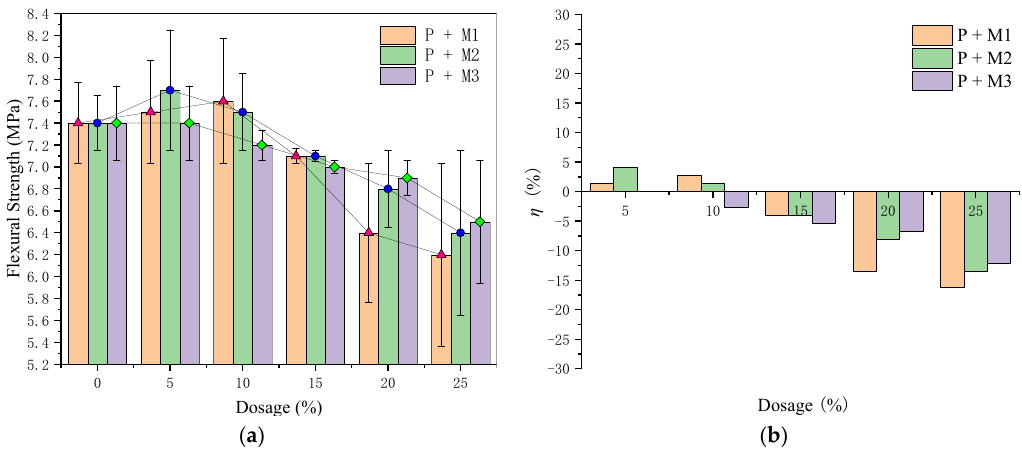
Figure 8. Results of 28 d of flexural strength. ( a ) Flexural strength. ( b ) Efficiency of action.